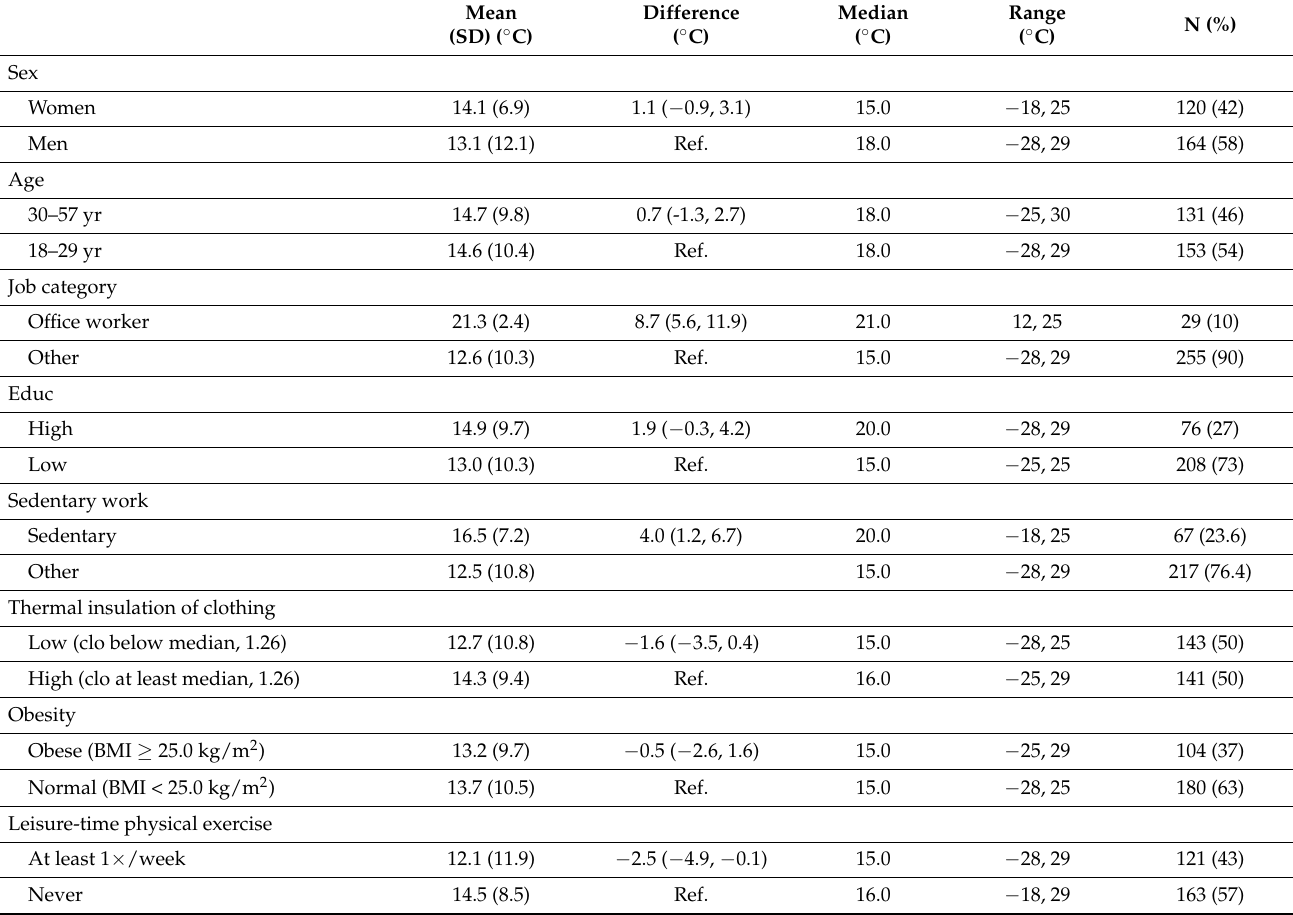
Table A2. Self-assessed threshold for cold temperature according to personal and workplace physical factors. Subsample of 284 participants having measurements of ambient temperature (Ta), relative humidity (RH), and air velocity (AV) at